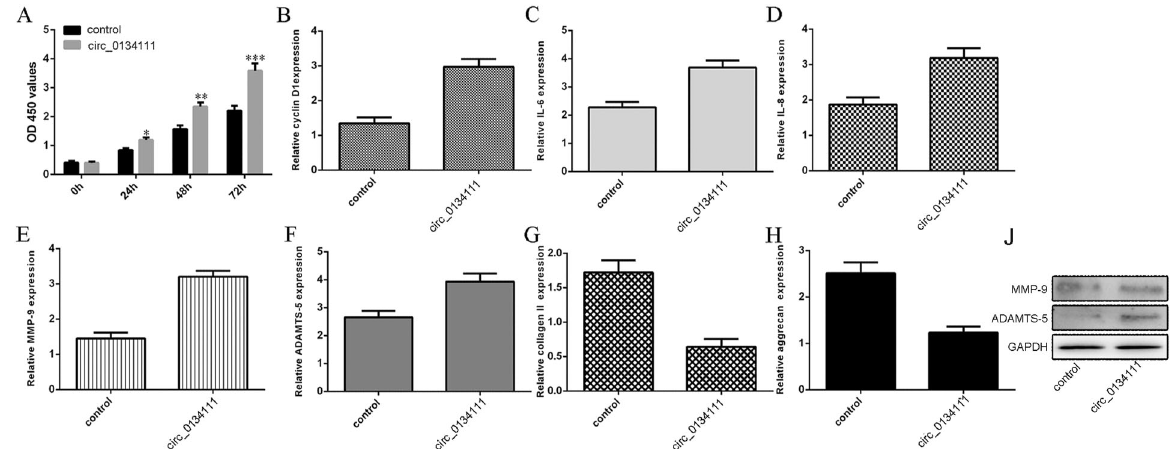
Fig. 5 circ_0134111 overexpression induced proliferation, pro-in fl ammatory cytokine secretion, and ECM degradation in NP cells. A circ_0134111 overexpression promoted NP cell proliferation as shown by the CCK-8 assay. B Ectopic expression of circ_0134111 increased the cyclin D1 expression. C – F Overexpression of circ_0134111 induced C IL-6, D IL-8, E MMP-9, and F ADAMTS-5 expression as shown by qRT- PCR assay. G, H The expression of type II collagen and aggrecan was determined by qRT-PCR assay. Ectopic expression of circ_0134111